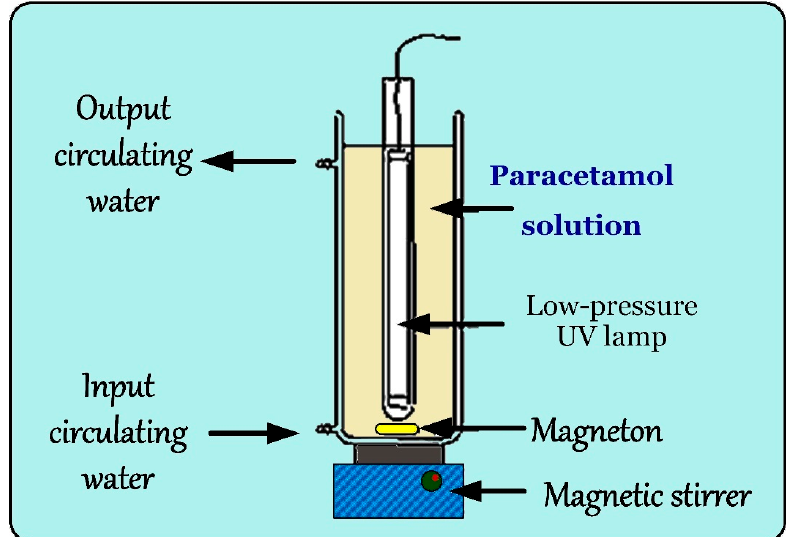
Figure 1. Experiential design for degradation of paracetamol by the UV/ chlorine system.